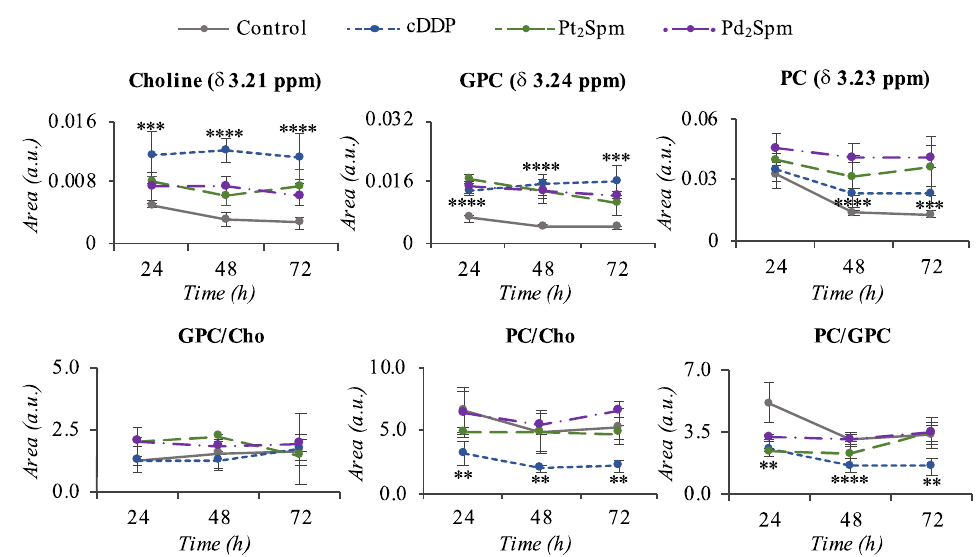
Figure 6. Relative changes in choline metabolite levels. Time course graphs (peak areas normalized by total spectral area, as a function of time) of choline metabolites and selected ratios, obtained for aqueous extracts of MG-63 cells under control conditions (grey solid line), exposed to 30 µ M cDDP (blue dotted line), 240 µ M Pt 2 Spm (green long dashed line) or 24 µ M Pd 2 Spm (purple two-dashed line). ✽✽ p -value < 0.01; ✽✽✽ p -value < 0.001; ✽✽✽✽ p -value < 0.0001, however these indications are only indicated for cDDP, for the sake of clarity, and the authors are guided to Tables S2 to S5 or Figure 4 for complete information on statistical relevance. GPC: glycerophosphocholine; PC: phosphocho- line.